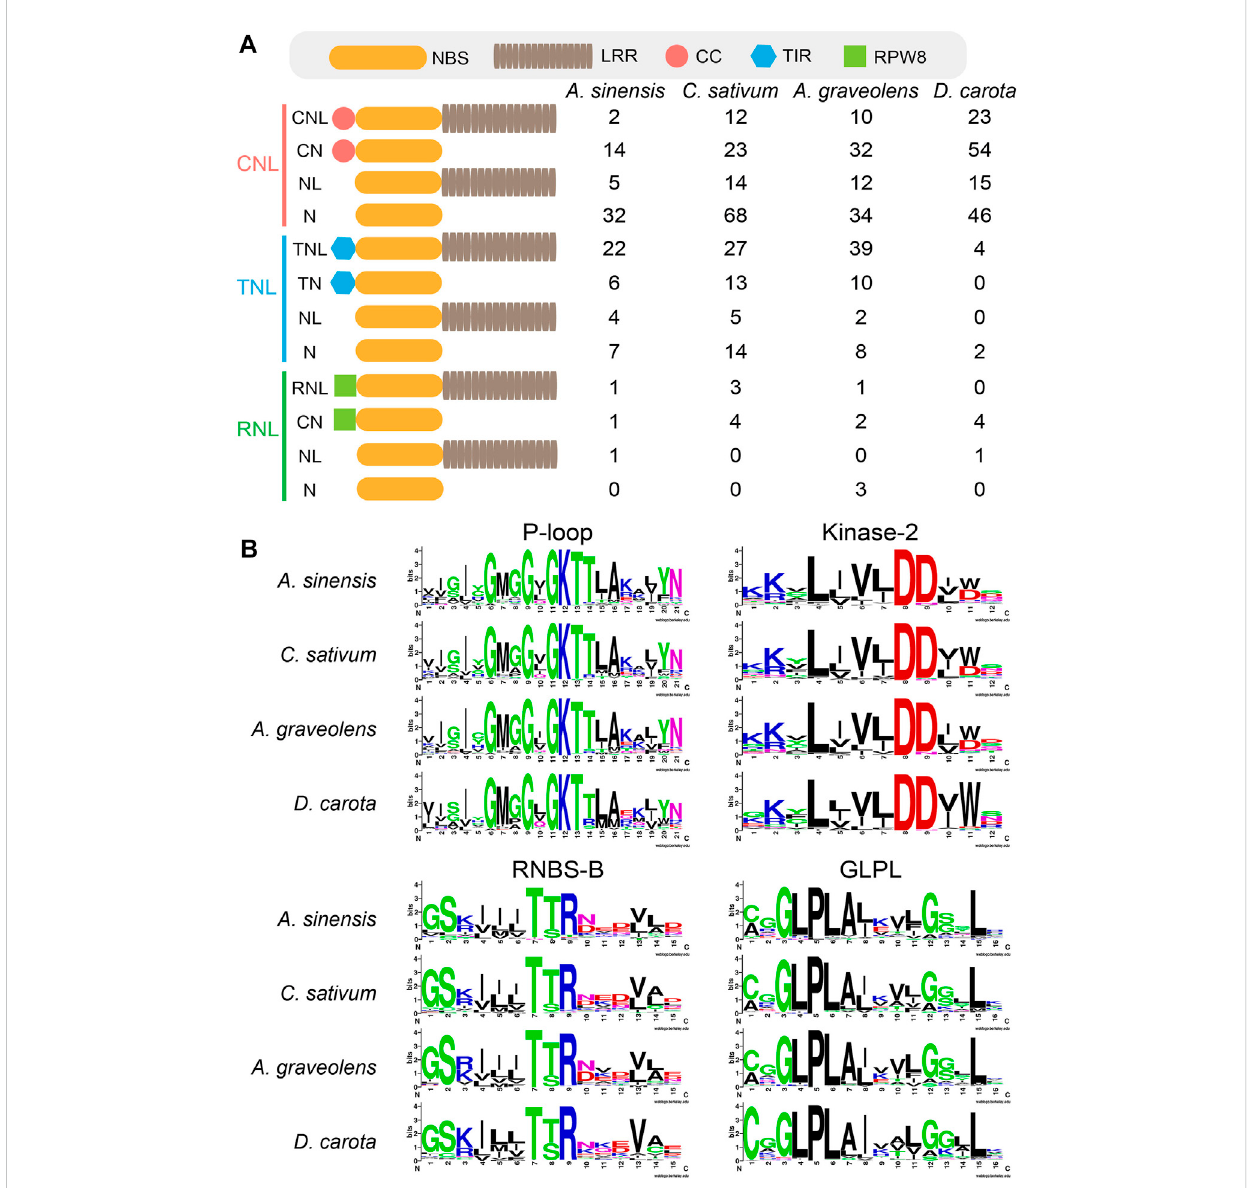
FIGURE 1 Domain structures and key motifs of NLR genes in four Apiaceae species. (A) Domain compositions and arrangements of NLR proteins encoded by the identi fi ed NLR genes from four Apiaceae species. C, CC domain; T, TIR domain; R, RPW8 domain; N, NBS domain; L, LRR domain. (B) Four key motifs in the conserved NBS domains from four Apiaceae